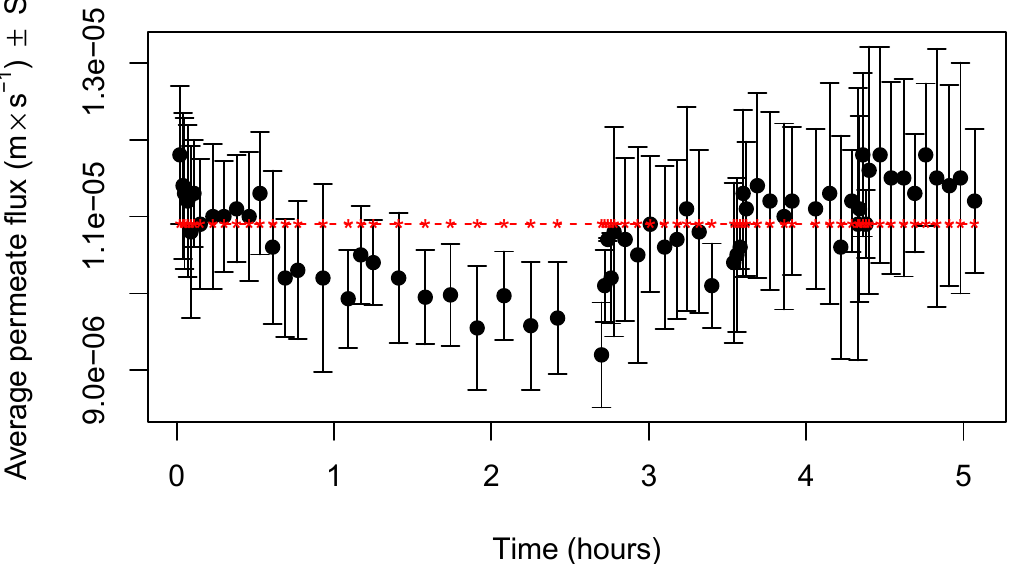
Figure 3. Variation of permeate fluxes ( ± standard deviation) with time, during the process of UF/DF, obtained with membranes ETNA01PP (n = 3 experiments), at a transmembrane pressure of 0.2 MPa.